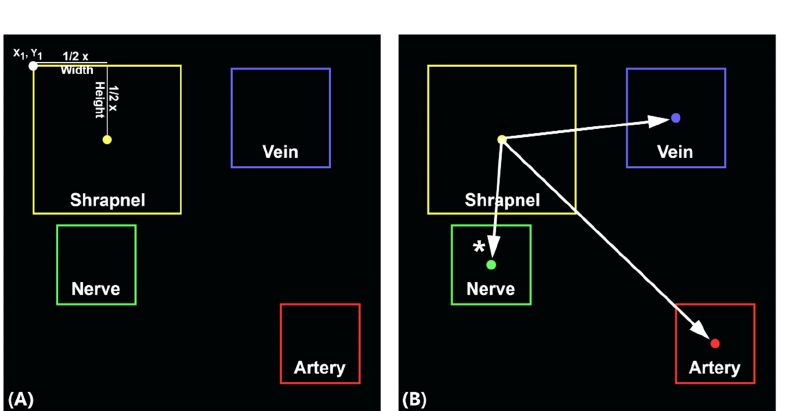
Figure 3. Diagram of triage metric calculation. ( A ) Measurements for the triage metric were based on object detection predictions for images with shrapnel, vein, artery, and nerve predictions. Prediction coordinates were recorded as (X 1 , Y 1 , Width, Height) where X 1 and Y 1 refer to the top left corner of the prediction window as shown. Midpoints of each prediction window, indicated by col- ored dots for each bounding box, were determined by adding ½ the width to the X 1 coordinate and adding ½ the height to the Y 1 coordinate. ( B ) Distance formula was used to calculate the distance (in pixels) between the shrapnel prediction and vein, artery, and nerve features. The minimum dis- tance indicates which neurovascular feature is closest to shrapnel, which is the value selected as the triage metric; for this example, the shrapnel-nerve distance would be the minimal distance (as indi- cated by *, in pixel units). In Equation (1), 𝑥 (cid:2870) and 𝑦 (cid:2870) refer to midpoint coordinates for the shrapnel prediction window, and 𝑥 (cid:2869) and 𝑦 (cid:2869) refer to midpoint coordinates for the vein, artery, or nerve pre-